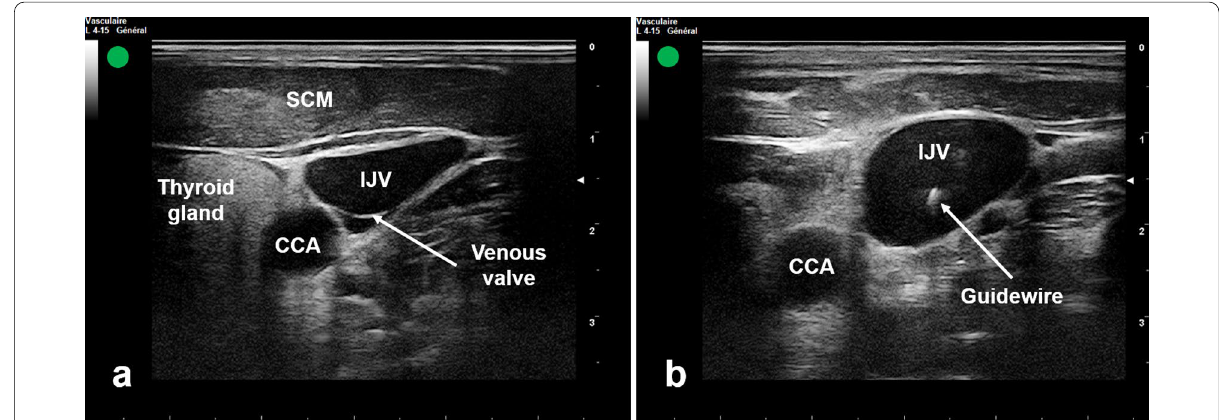
Fig. 1 Ultrasound-guided IJV catheterization using the short-axis view of the vein in combination with out-of-plane needle approach. a Ultrasound visualization of IJV and CCA. b Ultrasound visualization of the guidewire in the IJV. IJV internal jugular vein, CCA common carotid artery, SCM sternocleidomastoid muscle